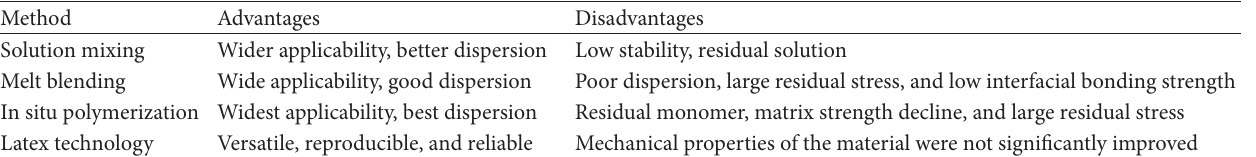
Table 1: Comparison of CNTs/polymer composites with various fabricating